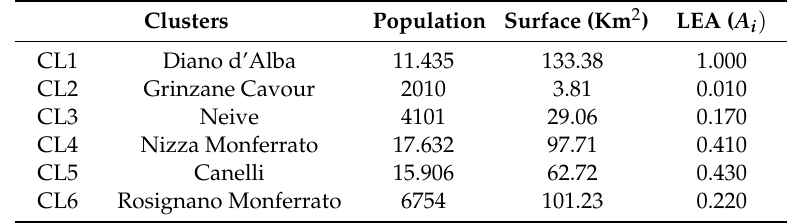
Table 6. Parameters for the dynamic model for the LRM landscape (core zones